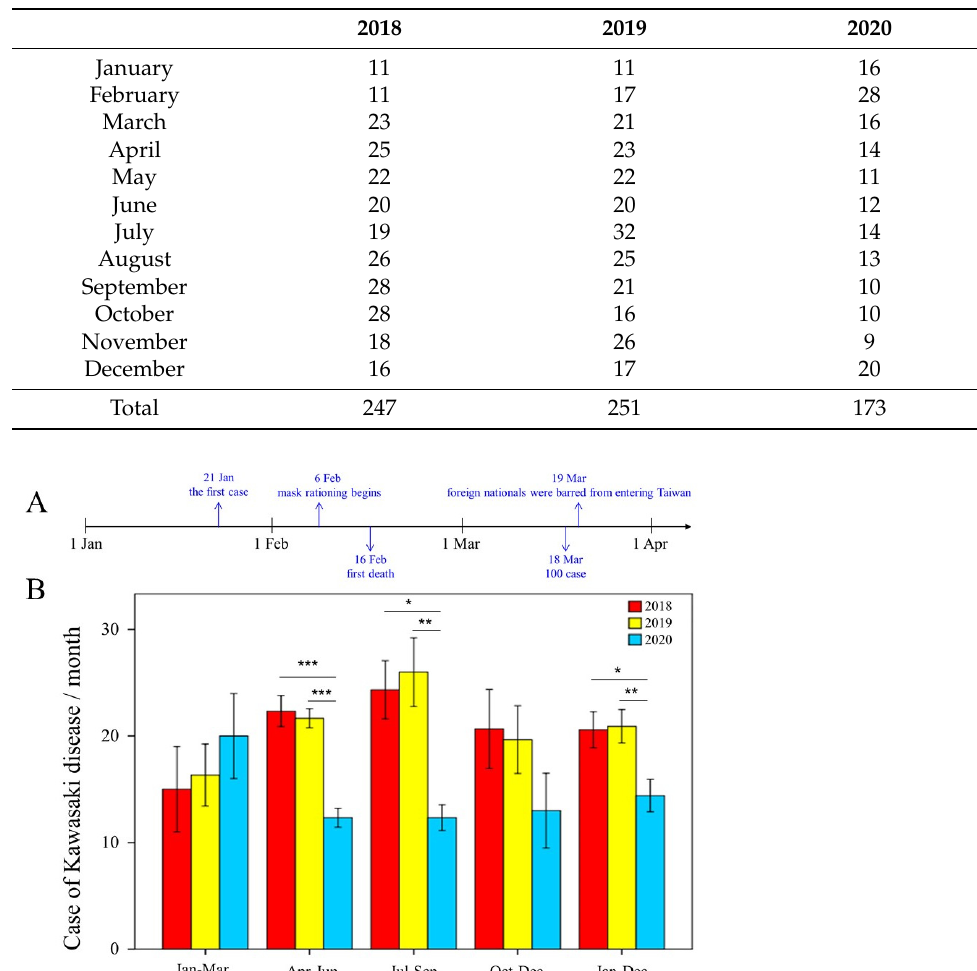
Figure 1. ( A ) Timeline for COVID-19 cases in Taiwan before 1 April. ( B ) Comparison of the average monthly numbers of KD cases in Chang Gung Memorial Hospital (CGMH) from 2018 to 2020. The CGMH consists of a network of seven hospital branches, with a total of 10,050 beds, and provides Taiwan’s largest and most comprehensive healthcare services. Compared with 2018 and 2019, there was no significant difference in KD cases in the first quarter of 2020 ( p = 0.267 and 0.334, respec- tively), but the number of KD patients decreased significantly from April to September in 2020. All data are expressed as mean ± standard error. We used one-way analysis of variance with least sig- nificant (LSD) test for post-hoc testing to evaluate quantitative data. * Indicates p < 0.05, ** p < 0.01, *** p < 0.001. 3.2. No Change of the Presentation Kawasaki Disease and Percentage of IVIG Resistance in 2020 We further analyzed the demographic data of 175 KD (26.8% of CGMH network) patients of our KD center in the Kaohsiung-CGMH. As shown in Table 2, there was no significant difference in age, sex, KD presentation (typical or incomplete), and the per- centage of IVIG resistance in 2020 compared to 2019 and 2018. ( p > 0.05) Table 2. Baseline characteristics of patients with Kawasaki disease. 2018